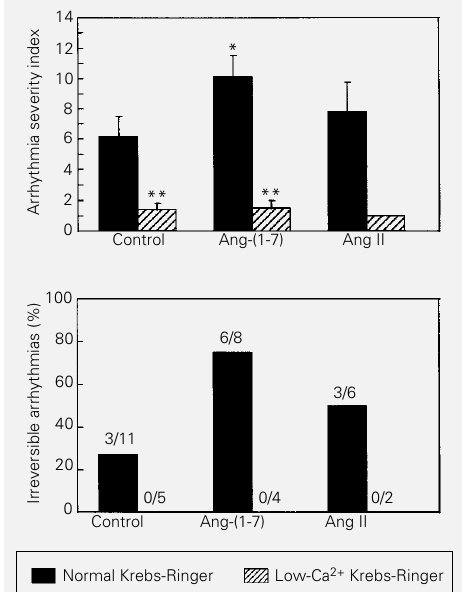
Figure 4 - Averaged arrhythmia severity index (upper panel) and percentage of irreversible ar- rhythmias (more than 30 min) (lower panel) upon reperfusion after 15 min of occlusion of the left anterior descending coro- nary artery in isolated rat hearts perfused with normal or low- Ca 2+ Krebs-Ringer solution (con- trol), normal or low-Ca 2+ Krebs- Ringer solution containing 27 nM Ang-(1-7) or normal or low- Ca 2+ Krebs-Ringer solution con- taining 27 nM Ang II. Numbers above the bars indicate the inci- dence of irreversible arrhythmias during the reperfusion period. *P<0.05 in comparison to the control group (Student t -test). **P<0.01 compared to the re- spective group submitted to nor- mal Krebs-Ringer solution (Stu- dent t